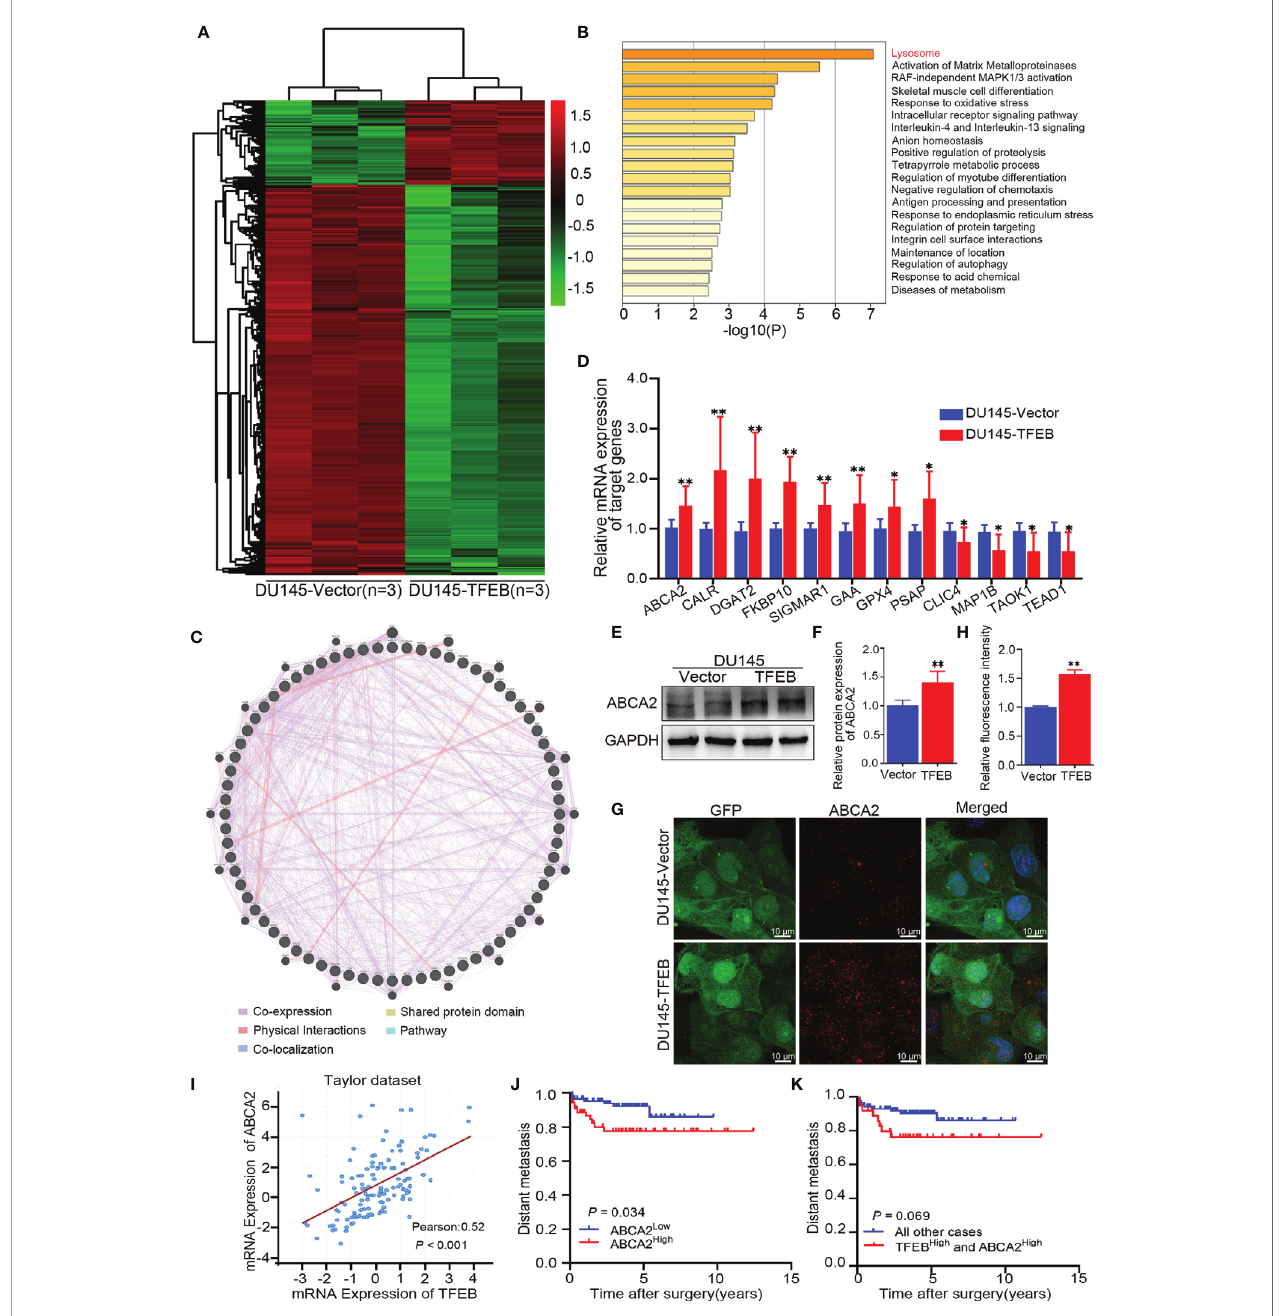
FIGURE 3 | Bioinformatics analysis in TFEB-overexpressing DU145 cell lines. (A) The transcription differential genes heat map in DU145-TFEB vs . DU145-vector. The result revealed there are 1,559 differentially expressed genes (DEGs) in TFEB-overexpressing DU145 cell line compared with vector group. (B) Kyoto Encyclopedia of Genes and Genomes analysis showed differentially expressed genes are enrichment in lysosome biogenesis, activation of matrix metalloproteinases and autophagy pathway. (C) Gene-gene interaction network of DEGs predicted using the GeneMANIA online tool. (D) Genes of interest validated by real-time RT- PCR. (E, F) Western-blot veri fi cation of ABCA2 gene in TFEB-overexpressing cell lines. Quantitative analysis of the western-blot from panel (F) . (G, H) Immuno fl uorescence of ABCA2 in DU145cell lines. Quantitative relative fl uorescence intensity of ABCA2 from (G) . (I) The correlation between TFEB and ABCA2 in Taylor dataset. (J) Kaplan-Meier curves representing metastasis-free endpoint survival of ABCA2 status in Taylor dataset (p=0.034). (K) Kaplan-Meier curves representing metastasis-free endpoint survival of combined TFEB high expression and ABCA2 high expression in Taylor dataset (p=0.069). Statistical analysis was from three independent experiments and is presented as mean ± SD. * p < 0.05, ** p < 0.01 compared with control